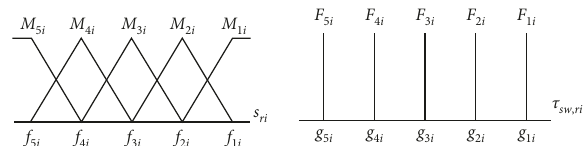
Figure 1: Membership functions of the fuzzy switching